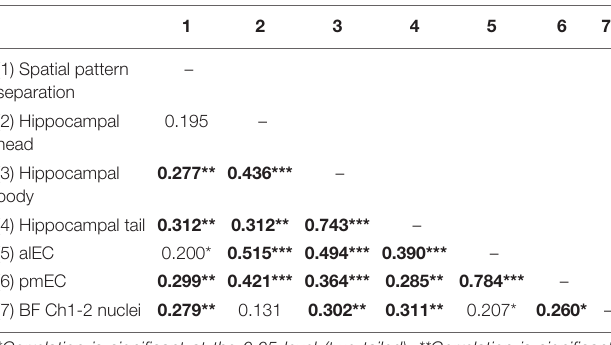
TABLE 3 | Correlation matrix of spatial pattern separation performance and volumes of specific hippocampal and entorhinal cortex subregions and basal forebrain Ch1-2 nuclei.